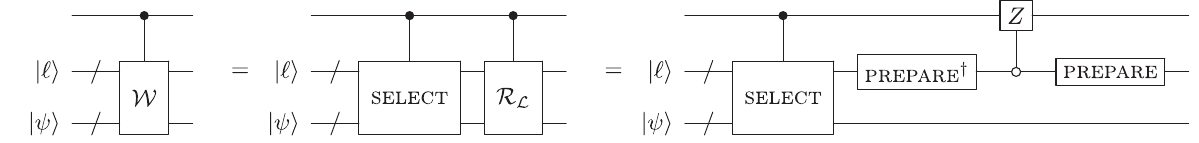
FIG. 1. A circuit realizing the Szegedy quantum walk operator W controlled on an ancilla qubit. The last three gates in the circuit on the right constitute the reflection R controlled on an ancilla. Note that the Z gate with the 0-control is actually controlled on the zero L state of the entire j l i register and not just a single qubit. Accordingly, implementation of that controlled Z has T complexity O ð log L Þ , where log L is the size of the j l i register. However, that overhead is always negligible compared to the cost of the PREPARE and SELECT operators in the constructions of this